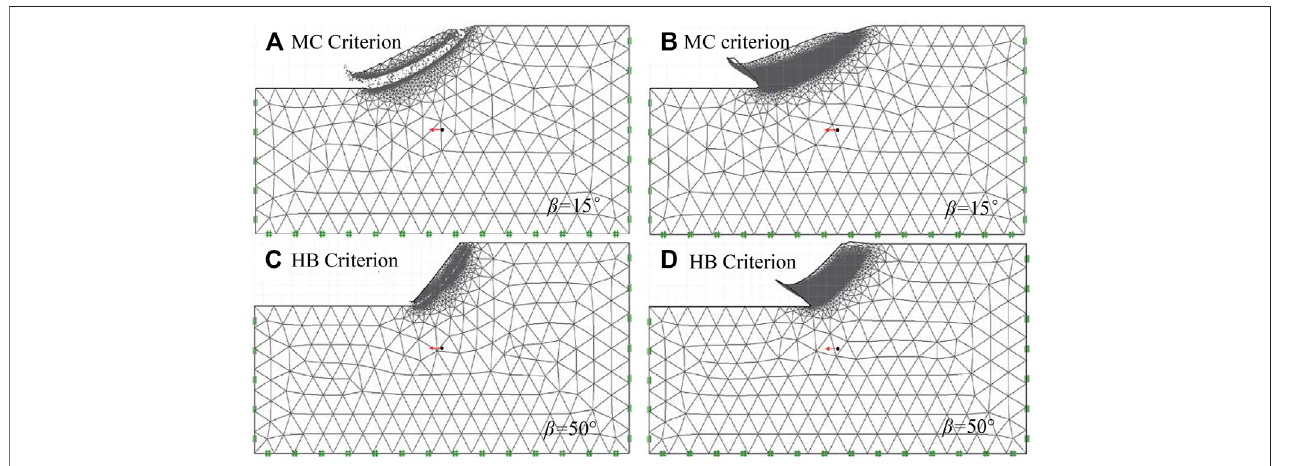
FIGURE 2 | Examples of fi nite element discretization: (A – C) lower-bound simulations and (B – D) upper-bound simulations.